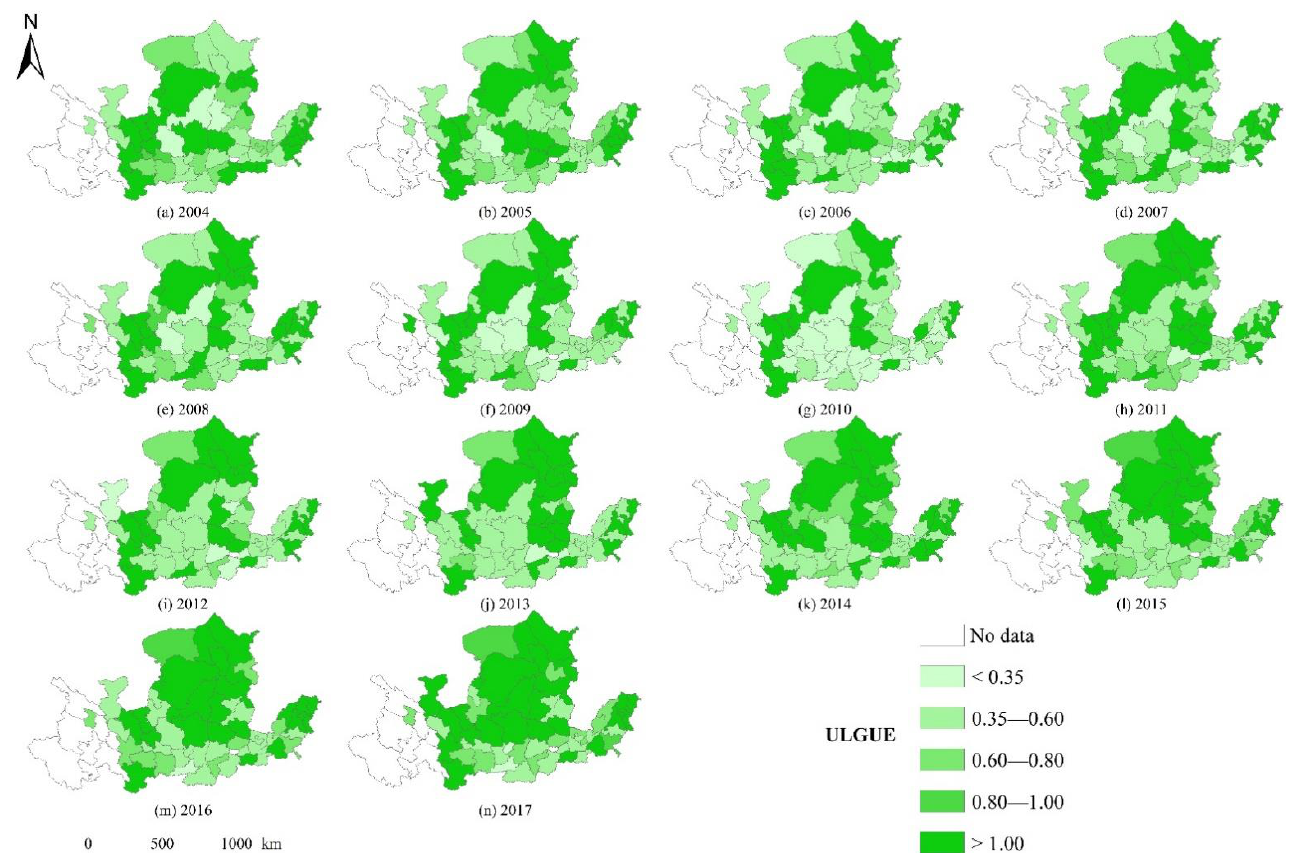
Figure 4. Spatial and temporal distribution patterns of ULGUE in the YRB from 2004 to 2017. ( a – n ) correspond to the years 2004 to 2017, respectively.